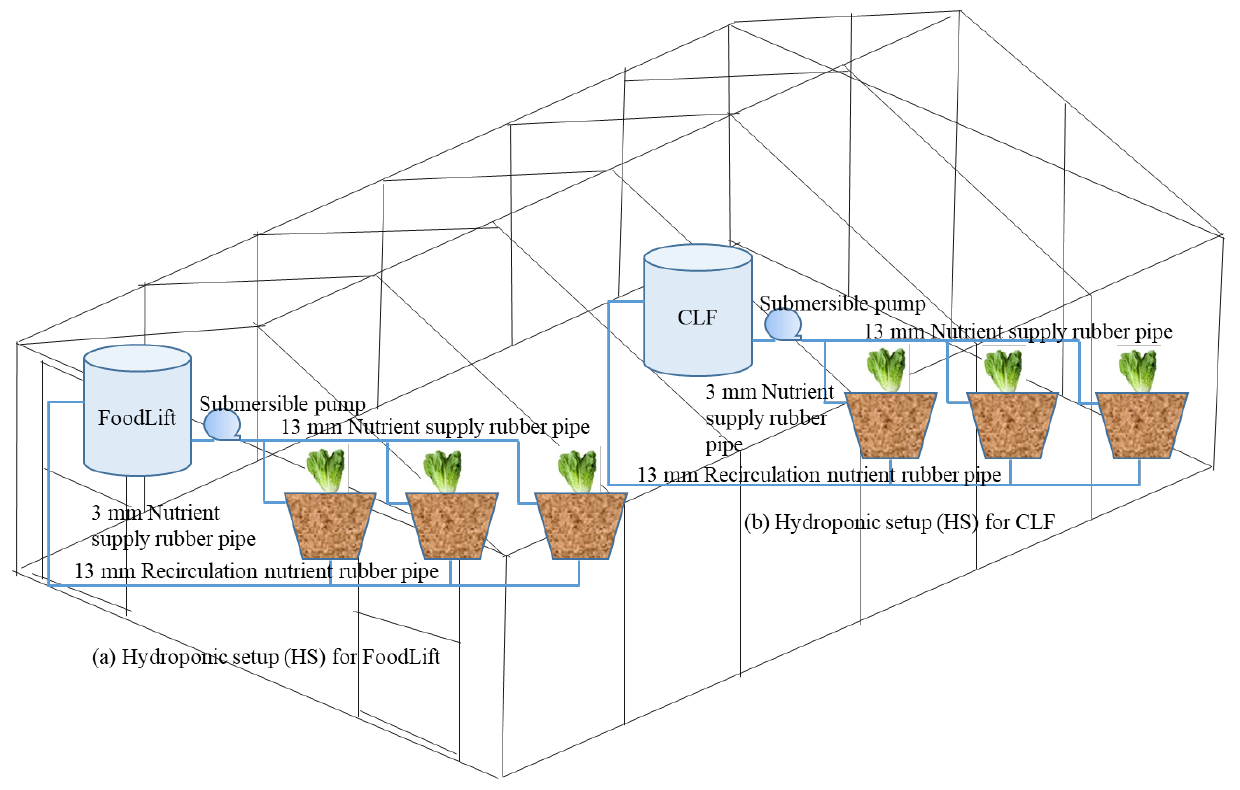
Figure 1. Experimental setup for hydroponic experiments. Table 2. Initial water quality parameters and nutrient concentrations in hydroponic feed